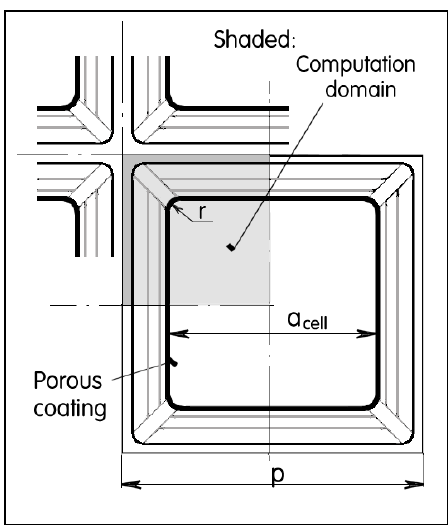
Figure 2. Typical square cross section of the passage in present-day ceramic matrices, seen in the flow direction. The key geometric factor is the cell width a cell . The gray quadrant is the domain in which numerical flowfield solution employing the geometric symmetries was performed.